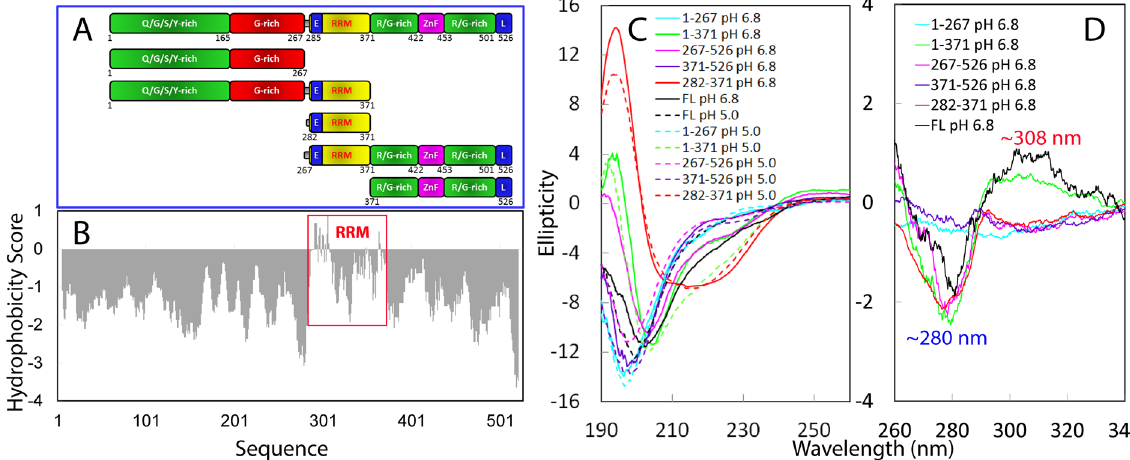
Figure 1. Domain organization and dissection of FUS. ( A ) FUS protein and its five differentially-dissected fragments studied here. The 526-residue FUS contains: (1) N-terminal low-sequence complexity (LC) region (1–267) including a QGSY-rich prion-like domain (1–165) and a G-rich region (166–267); RNA-recognition motif (RRM: 282–371); and C-terminal LC domain (371–526) including a RGG repeat region and a highly conserved nonclassical nuclear localization signal (L). ( B ) Kyte & Doolittle hydrophobic scale of FUS. The red box is used to indicate the RRM regions with positive scales. ( C ) Far-UV CD spectra of the full-length FUS and its five dissected fragments collected in 1-mm curvet at 25 °C at a protein concentration of 40 µ M in 1 mM phosphate buffers at pH 5.0 and pH 6.8 respectively. ( D ) Near-UV CD spectra of the full-length FUS and its five dissected fragments collected in 10-mm curvet at 25 °C at a protein concentration of 40 µ M in 1 mM phosphate buffers at pH